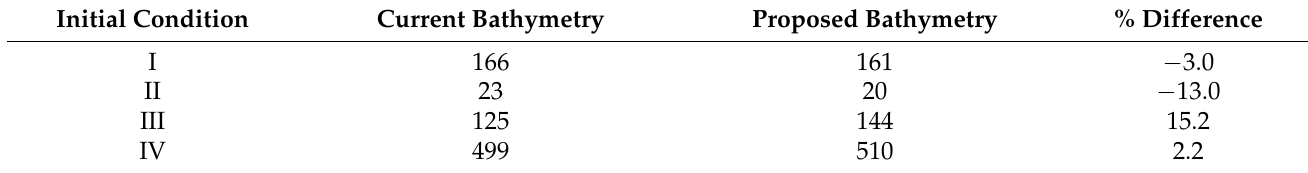
Table 5. Extreme river inflow condition successful larvae